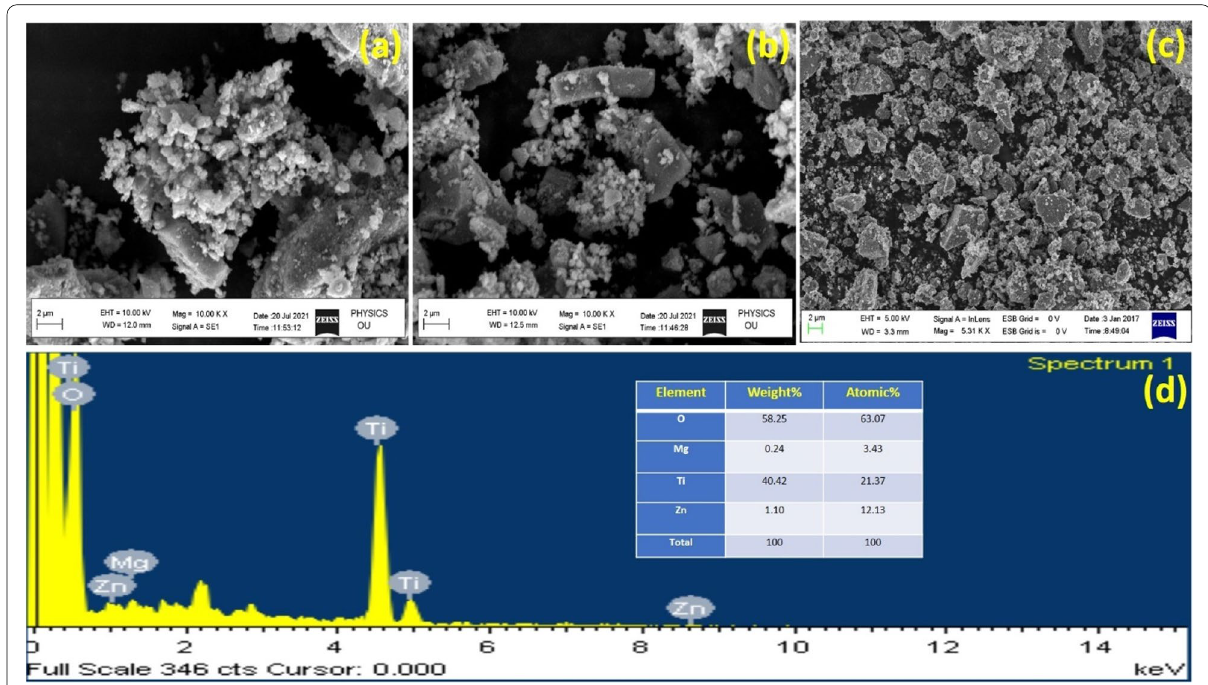
Fig. 9 a FESEM images of undoped TiO 2 , b ZMT4, c ZMT4S2 and d EDX spectrum of ZMT4